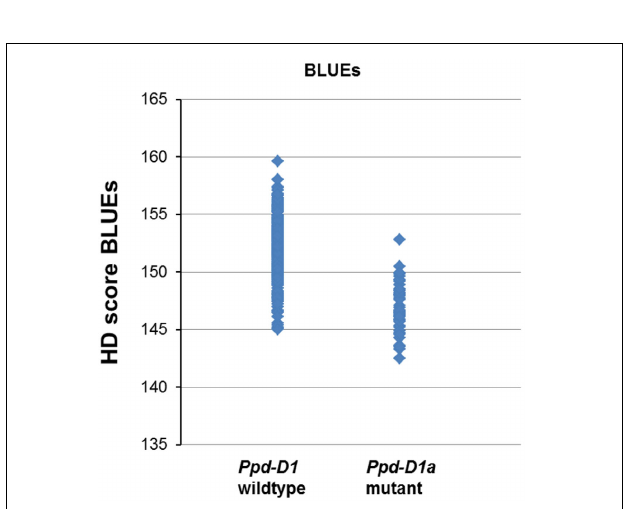
FIGURE 3 | Number of significant MTA for each (A) SSR and (B) SNP marker locus. The significant MTA per marker locus range from one to a maximum of nine according to the eight environments plus BLUEs.